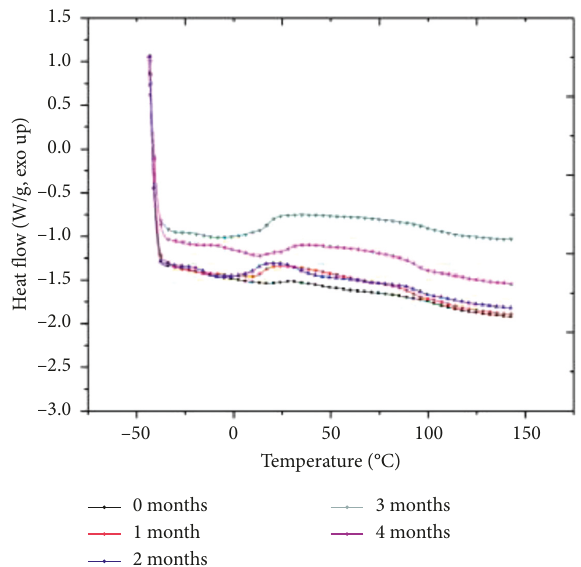
Figure 13: Differential scanning calorimetry curve for conditioned and control GFRP bars (adapted from